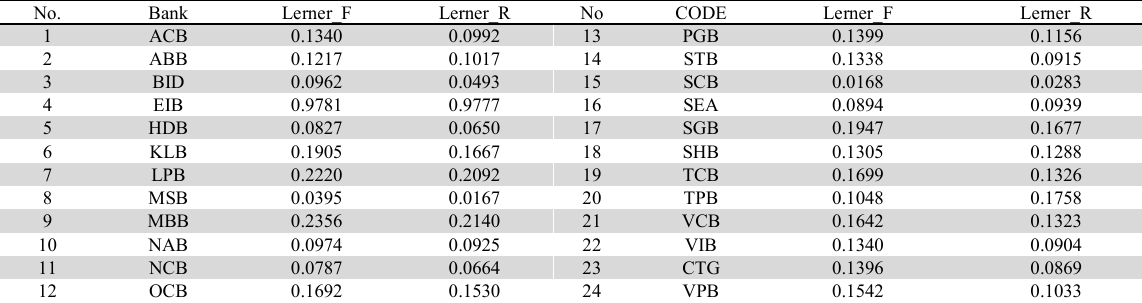
The results of the FEM and REM regression of the Lerner index by bank No.